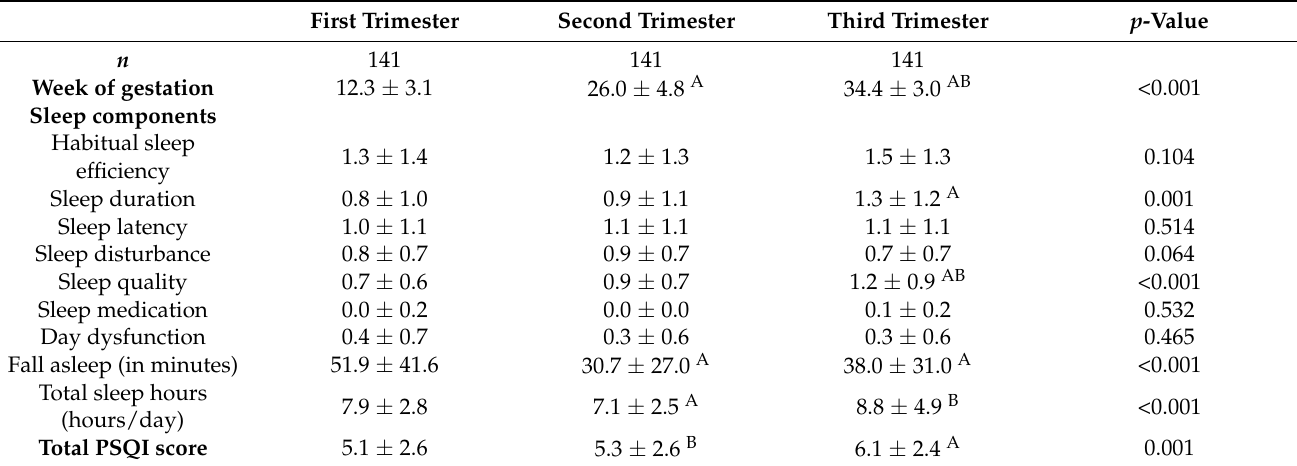
Table 3. Mean PSQI scores at each trimester visit.